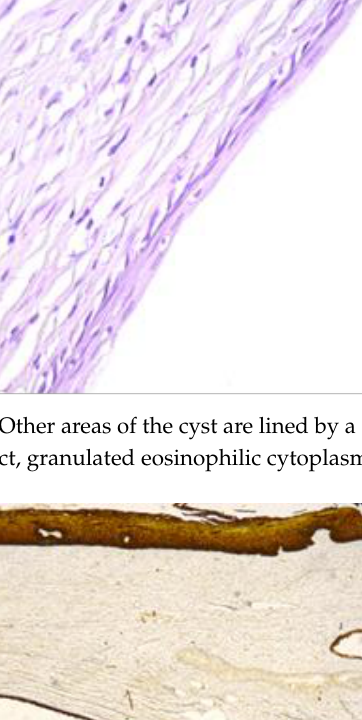
Figure 7. Cyst’s epithelium mark ed as intensively positive (CK 5/6, 40X). 3. Discussion The cervical localisation of an epidermal-type keratinocyte cyst is particularly unu- sual. The immunohistochemical studies of the specimens proved without any doubt that the cystic structure was indeed an epidermal cyst and the etiopathology of an epidermoid cyst with “classical” locali sation is probably very well understood. In this case, the eti- opathology of such a lesion located in the cervix is an ongoing debate. Some causes of it could be: local irritating conditions such as trauma, chronic inflammation, infection with HPV, squamous metaplasia, growth originating from vestigial structures and hetero- trophic intrapartum implants. The exact etiopathology is unknown, although animal re- search studies suggested that reminiscent vestigial structures are likely candidates to in- duce such a lesion [17]. The uterus, cervix and upper two-thirds of the vagina develop embryologically from the paired Müllerian ducts from their fused distal portion [23,24]. Despite the fact that epidermoid cysts are commonly seen localised in hair-bearing skin, diagnosing them at mucosa sites, such as in our case, is extremely rare. The associa- tion between HPV infection and the epidermoid cyst presence has been debated in many studies [25,26]. High-risk HPV strains are proven to be a carcinogenetic factor in the case of cervical cancer. Other studies try to determine whether there is any possible connection between HPV infections and malignant transformations in cases of mature cystic terato- mas. Chiang et al. [27] demonstrated that HPV might induce the transformation of ovary teratoma in squamous cell carcinoma. Many studies performed in the last decade demon- strated the role played by high-risk HPV strains (16, 18, 31, 33, 34, 35, 39, 45, 51, 52, 56, 58, 59, 66, 68 and 70) in the cervix cancer pathogenesis. One of the more exhaustive studies regarding the HPV role stated that 6, 11, 16, 30, 33, 36, 37, 38, 41, 48, 60, 72 and 73 subtypes might be found in the skin layer of epidermoid cysts [26,28 – 30]. A Korean study [9]